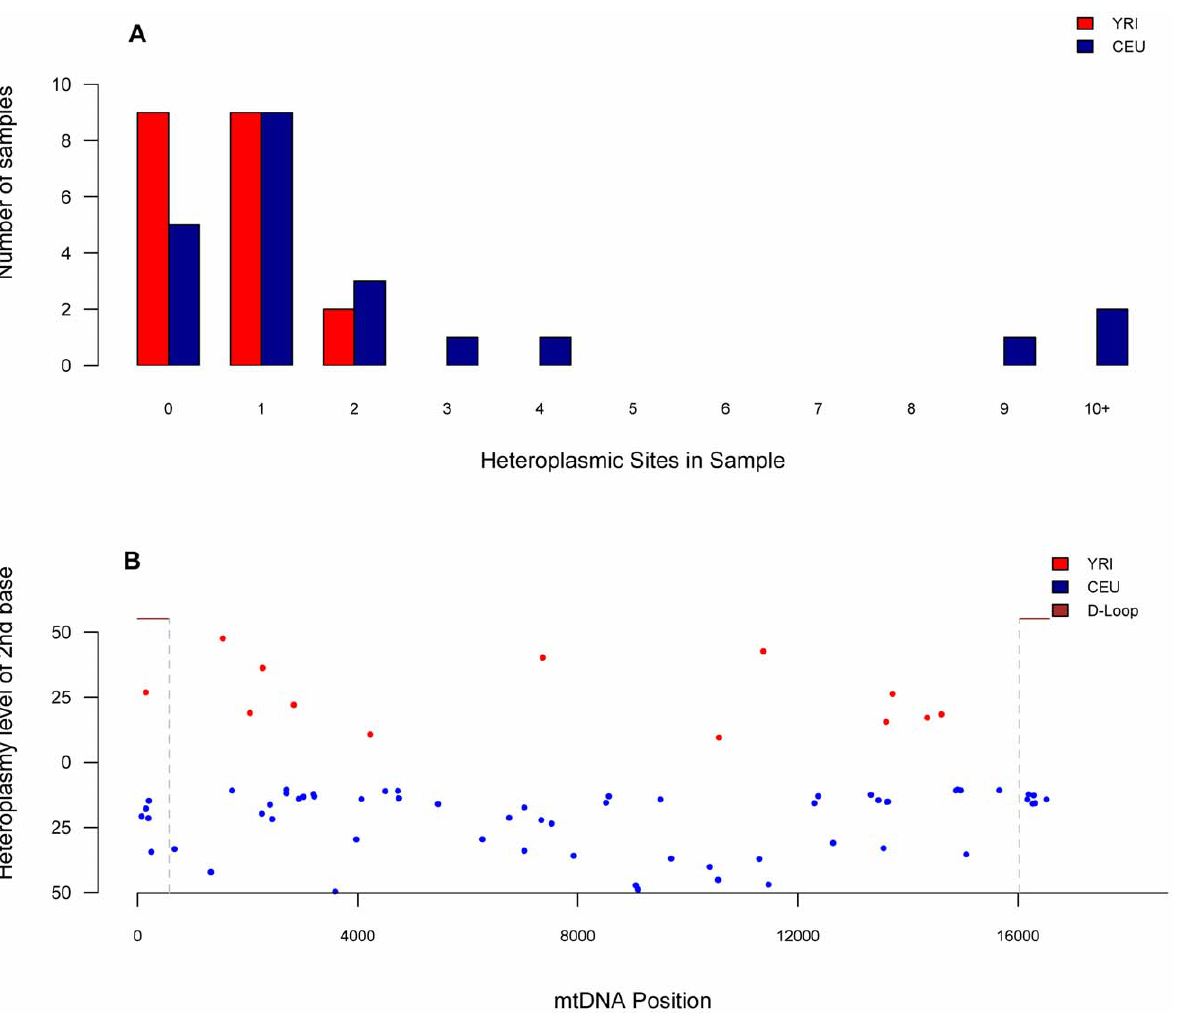
Figure 3. A. Heteroplasmic sites per sample. Total number of heteroplasmic sites found per sample for each YRI and CEU sample. B . Level of heteroplasmy per position across the mitochondrial genome . Top and bottom displays the level of heteroplasmy for all sites found in YRI and CEU samples, respectively, across the mitochondrial genome.